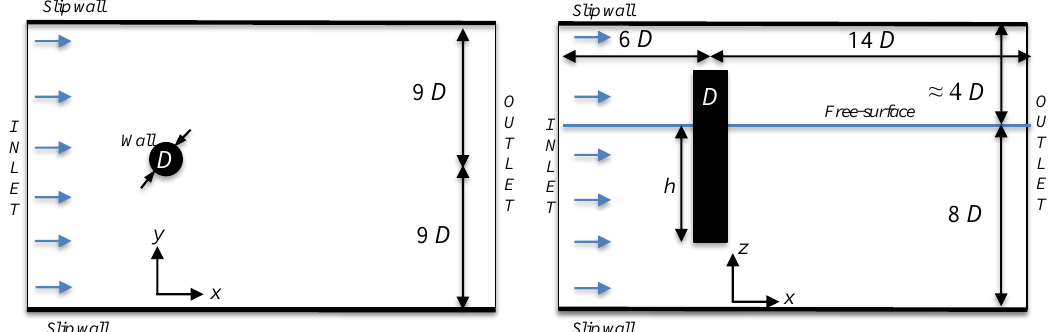
Figure 1. Schematic of the domain and boundary conditions for D = 5 cm. Top and side views of the numerical domain. The blue arrows indicate the inlet